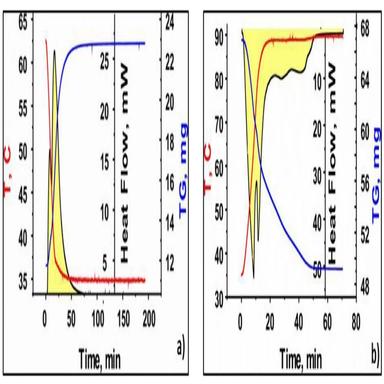
DSC/TG results obtained for: (a) water sorption at 35 °C with evaporation temperature of 10 °C; (b) water desorption at 85 °C with condensation temperature of 30 °C. (For interpretation of the references to color in this figure, the reader is referred to the web version of this article.)